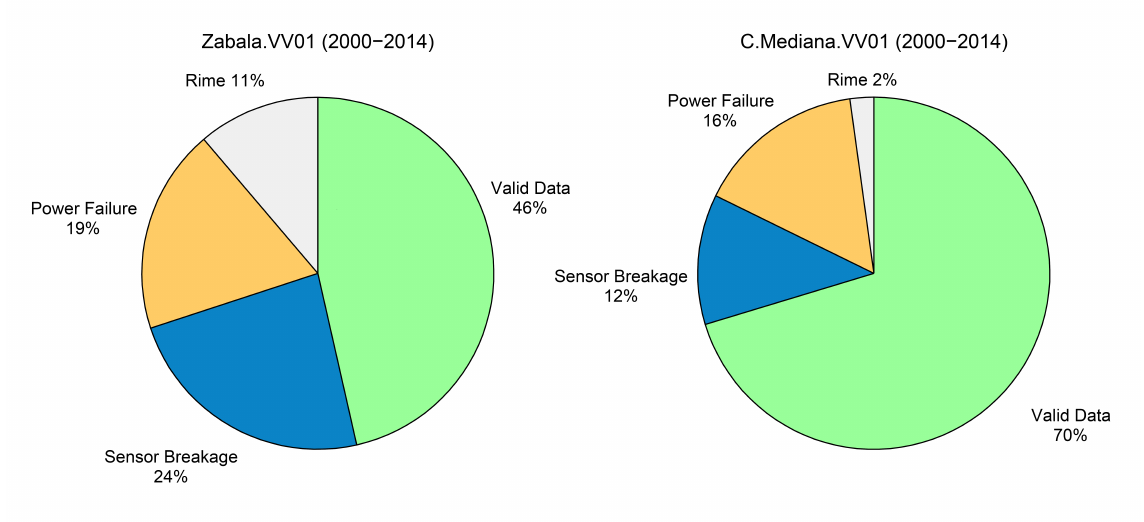
Figure 9. Percentage of factors that lead to wind speed data loss (rime, power failure and sensor breakage) and total valid data at Zabala and Cabeza Mediana